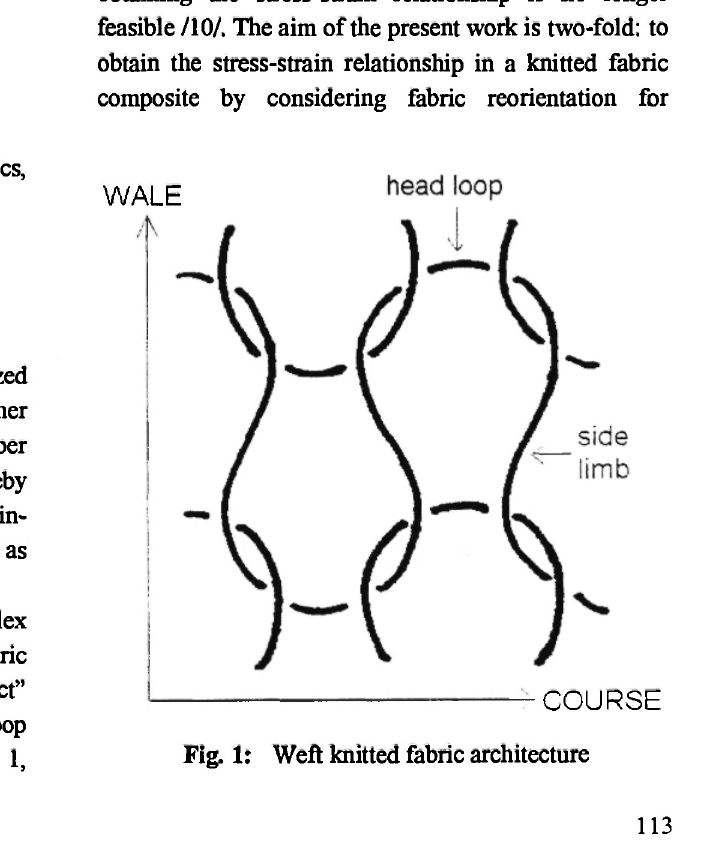
Fig. 1: Weft knitted fabric